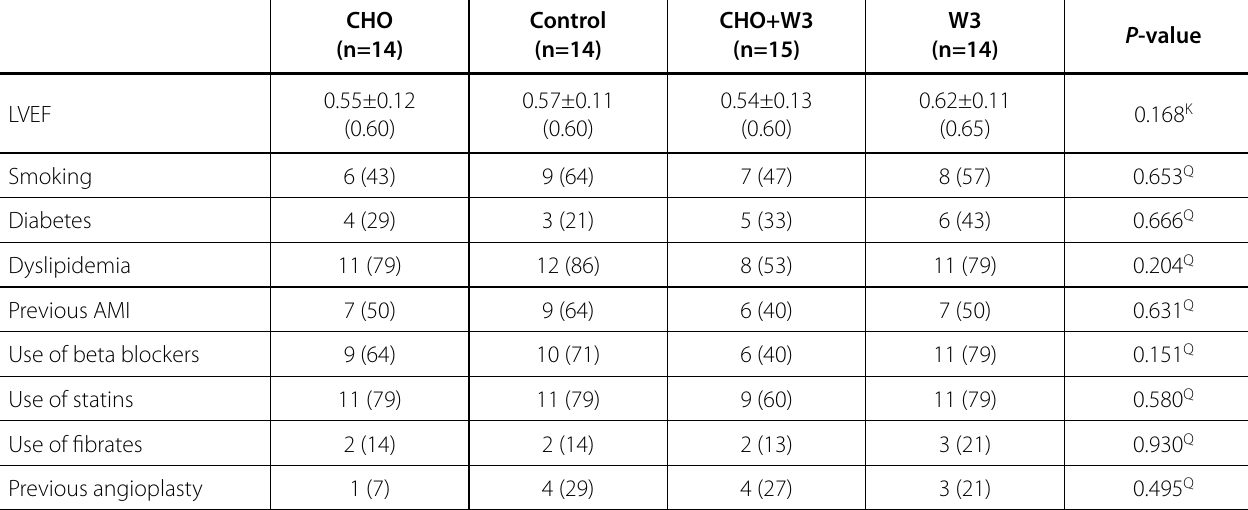
Table 2. Clinical data and risk factors for coronary disease in 57 patients undergoing on-pump CABG.